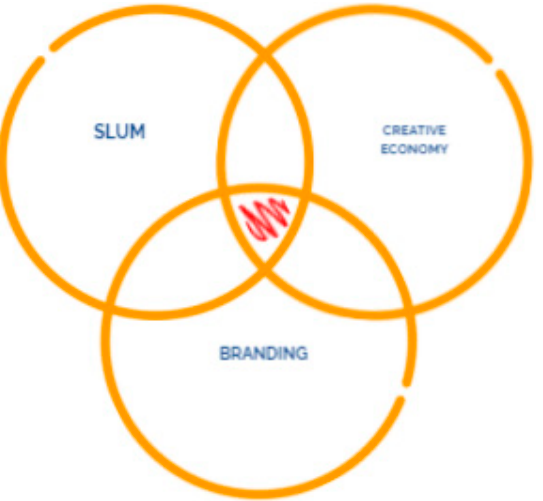
Figure 7. Graphic scheme of favela integration with creative economy and branding.